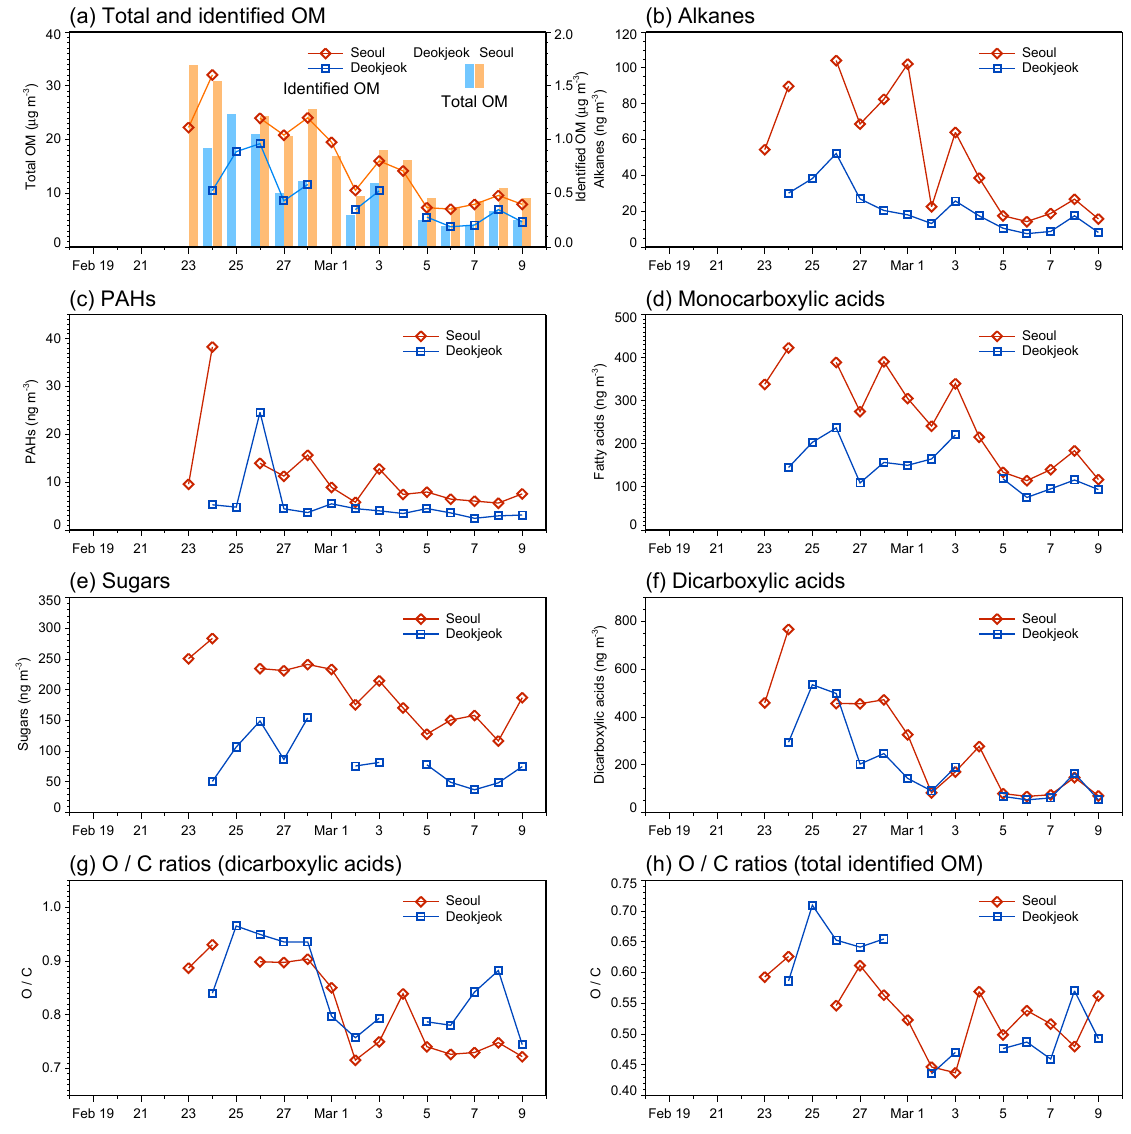
Figure 7. Daily time-series of (a) total identified OM and estimated total OM, (b) n -alkanes, (c) polycyclic aromatic hydrocarbons (PAHs), (d) monocarboxylic acids, (e) sugars, (f) dicarboxylic acids, (g) O / C of the dicarboxylic acids, and (h) O / C of the total identified OM at the KIST site in Seoul and the Deokjeok site for the analysis